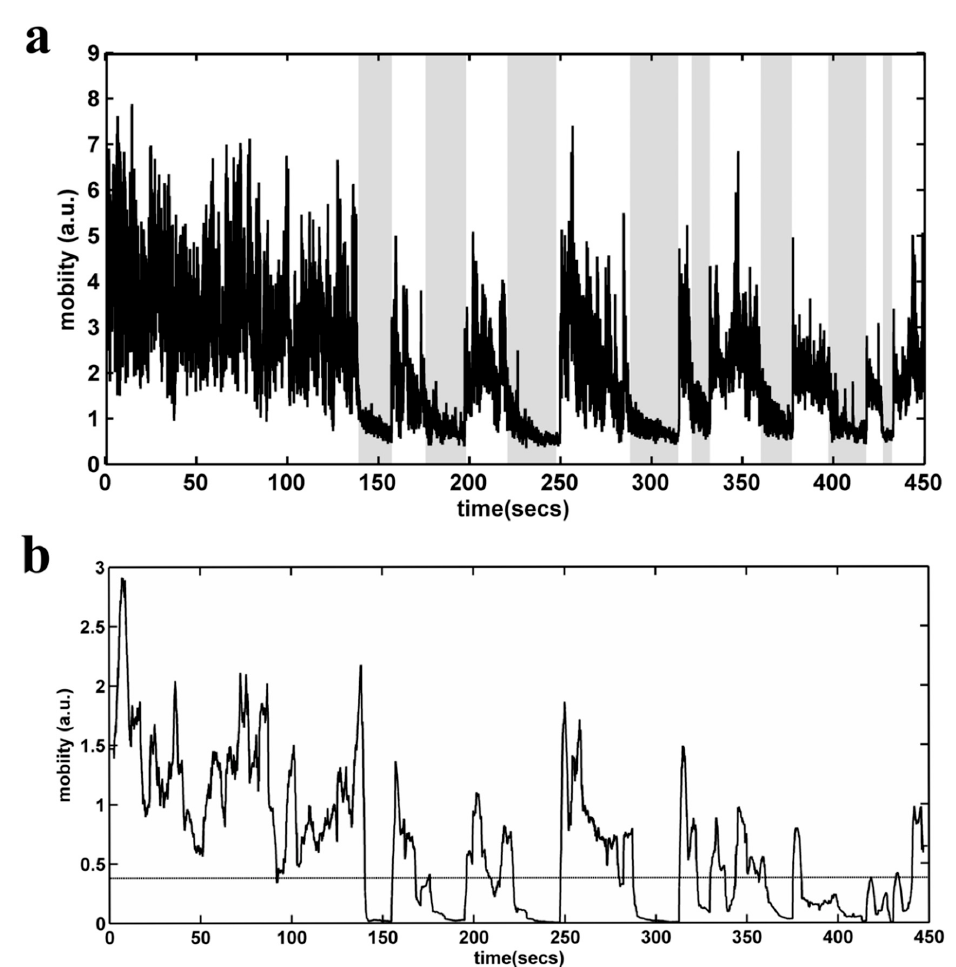
Figure 9. Automated behavioral analysis of the Tail Suspension Test. ( a ) Mobility time series (in arbitrary units) for each subject, constructed by calculating the absolute difference between each of the two subsequent gray level frames. Shaded regions define possible areas of false detection in the case of a simple threshold detector. ( b ) Mobility time series, after the application of a moving variance estimator in the form of a sliding window. The dashed line depicts the selected threshold.